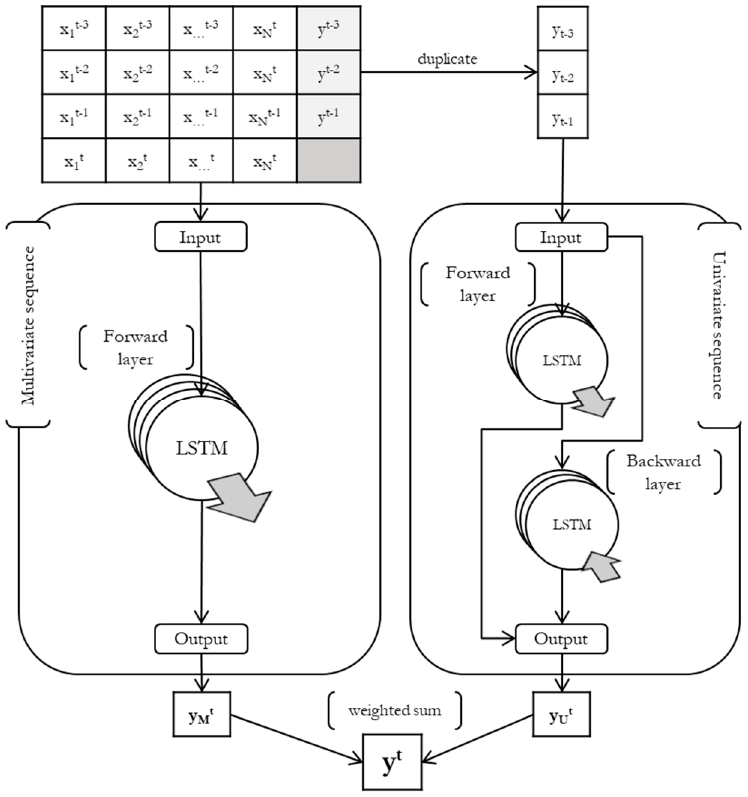
Figure 5. Architecture of the proposed LSTM network.